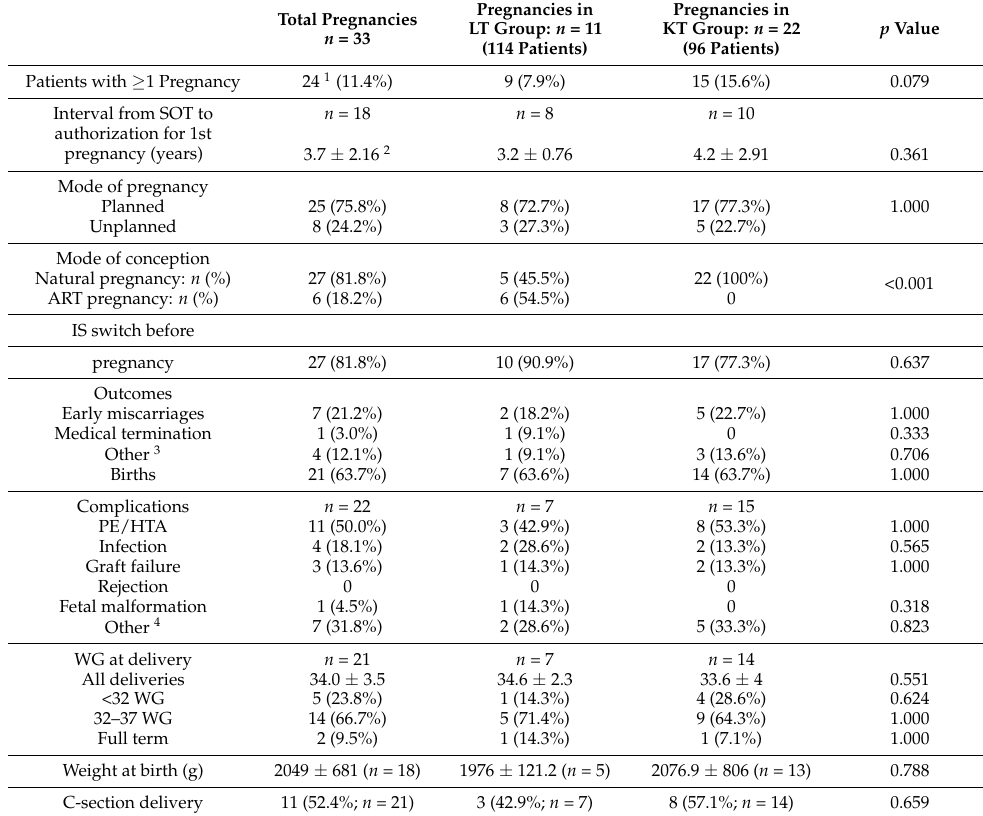
Table 3. Characteristics of pregnancies following